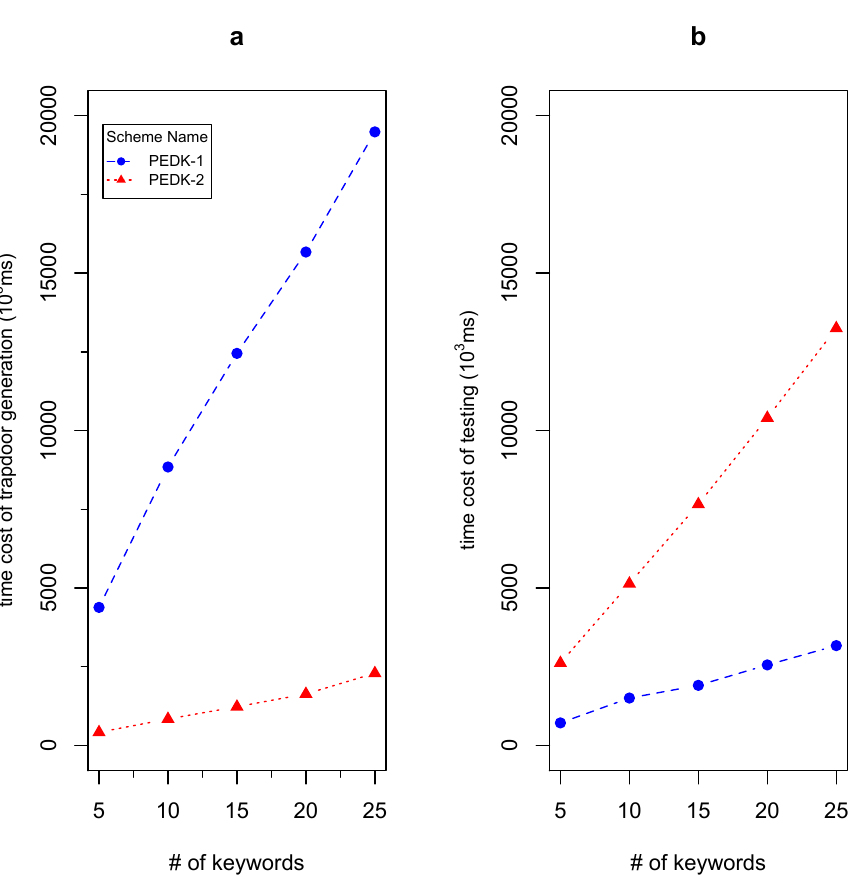
Figure 4. Impact of m on the time cost of trapdoor generation ( a ) and testing ( b ) in PEDK-1 and PEDK-2. ( D = 100, n = 25, m = { 5,10,15,20,25 } ). B.2: Storage